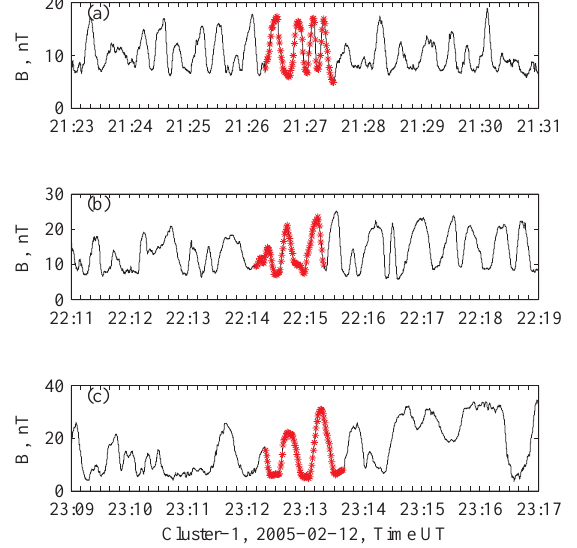
Fig. 5. Zoom at Fig. 1 showing magnetic pulsations in three differ- ent times corresponding to labels a, b, c. Notice soliton-like char- acter of the measured pulsations which persists continuously dur- ing many hours. Marked intervals are subject to timing analysis in Fig.